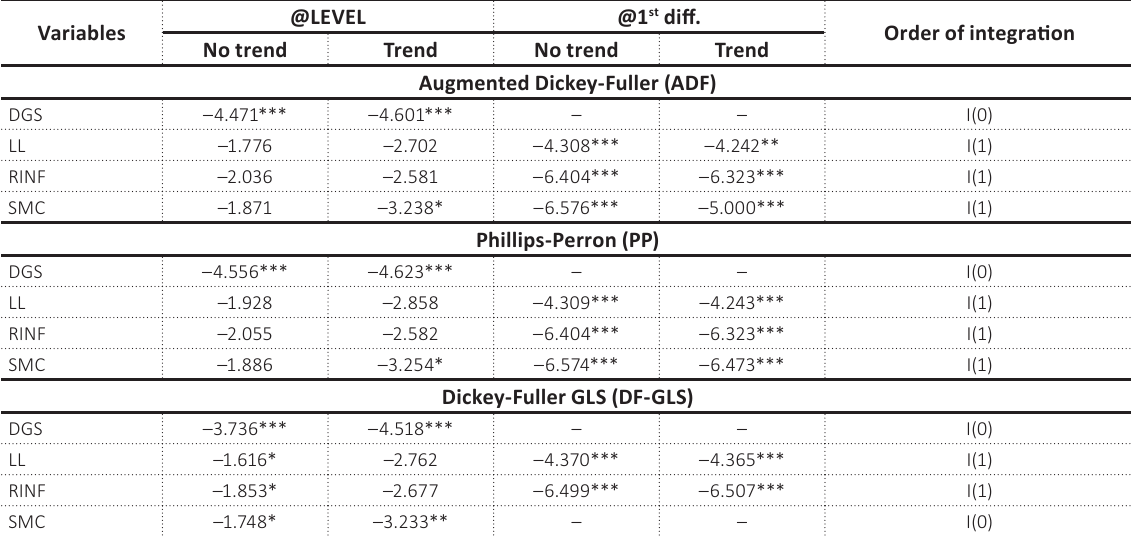
Table 2. Stationarity test